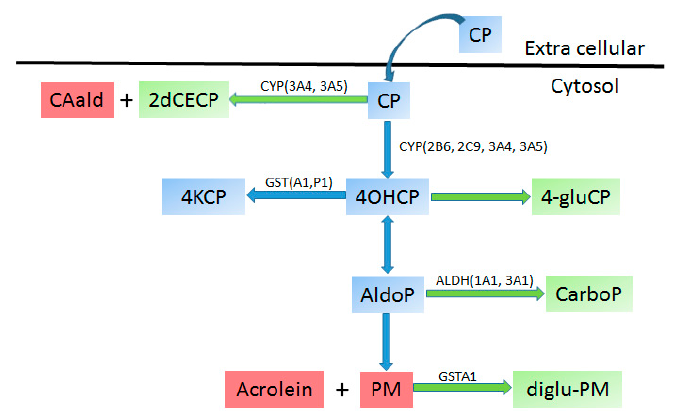
Figure 4. Metabolism of Cyclophophamide. Metabolites: Aldophoshphamide (AldoP), Chloroacetaldehyde (CAald), cyclophosphamide (CP), Carbophosphamide (CarboP), diglutathionylphosphoramide mustard (diglu-PM), Phosphoramide mustard (PM), 2-Dechloroethylcyclophosphamide (2dCECP), 4-Ketocyclophosphamide (4KCP). Enzymes: Cytochrome P450 3A4, 3A5, 2B6, 2C9 (CYP3A4, CYP3A5, CYP2B6, CYP2C9), Glutathione S -transferase alpha1, pi1 (GSTA1 GSTP1), Aldehyde dehydrogenase 1A1, 3A1 (ALDH1A1, ALDH3A1). Colors: blue—prodrug, drug; green—inactive metabolites, red—toxic metabolites (adapted from [22,299]).